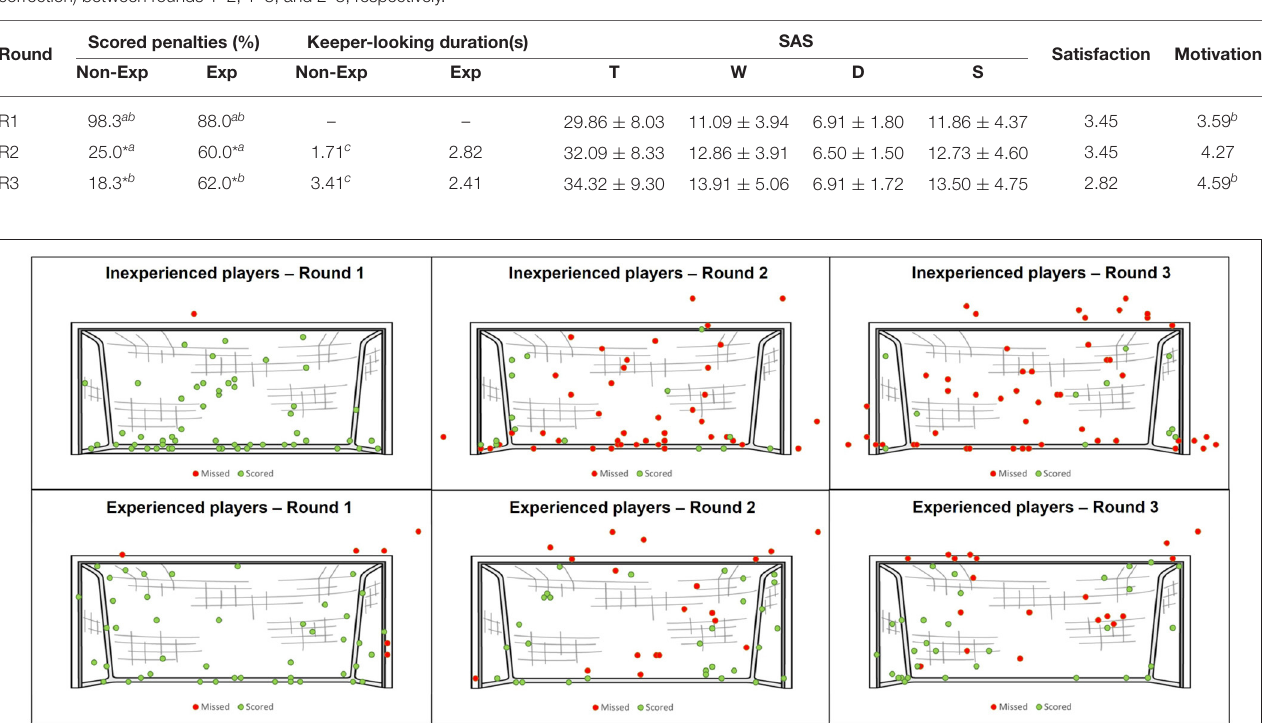
were lowest in the first round and highest in the last